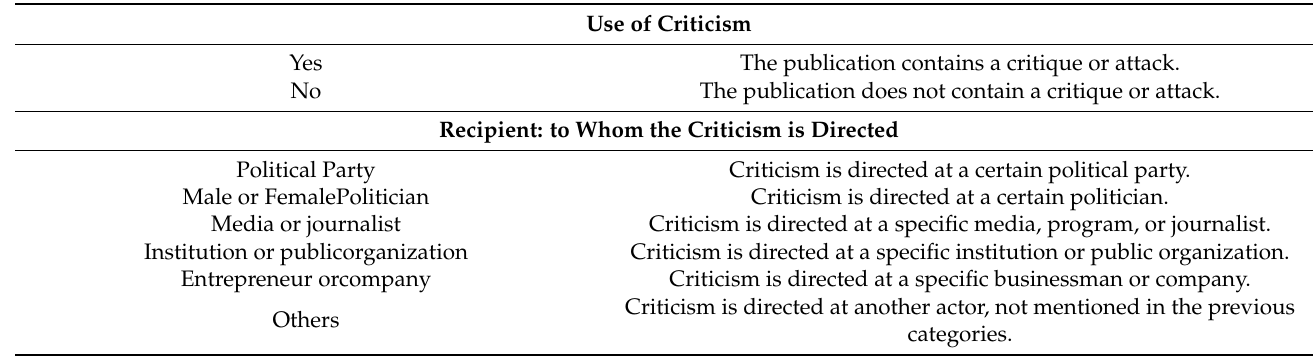
Table 2. Analysis